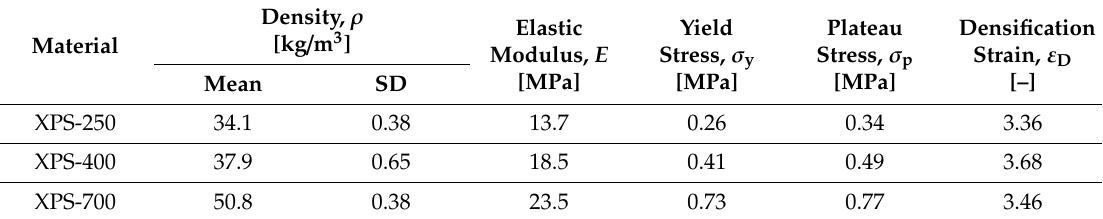
Table 2. Material properties (mean values based on five tests) of the foam samples in thickness (normal) direction (ND)